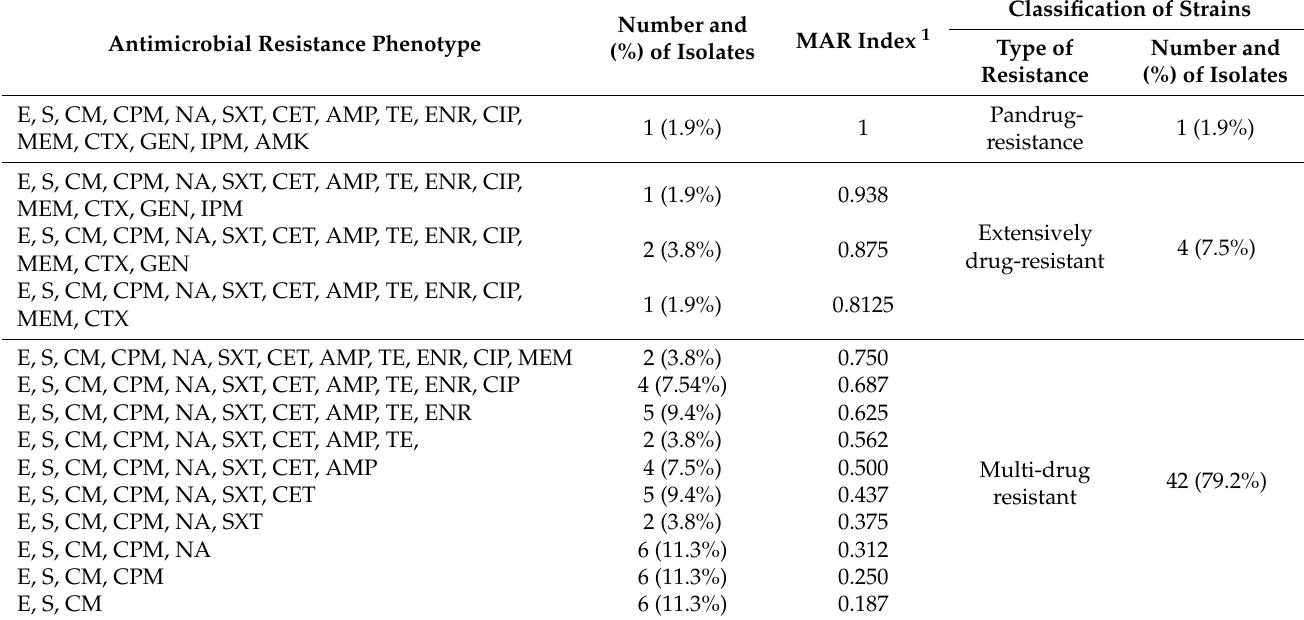
Table 4. Classification of Salmonella isolates (n = 53) based on their antimicrobial resistance against the 16 tested